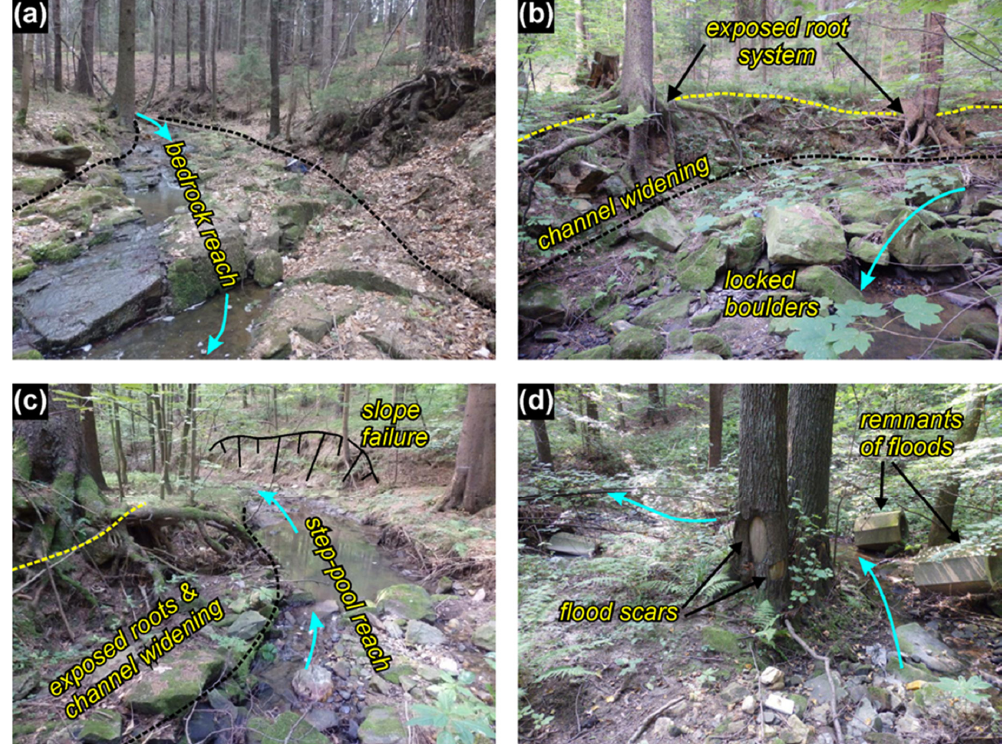
Figure 2. Morphological features of the study channel reach: ( a ) channel bottom composed of gneiss bedrock; ( b ) channel widening evidenced by the system of exposed tree roots in boulder-step reach; ( c ) step-pool reach with the presence of channel widening and fresh, shallow slope failure; ( d ) flood scars (higher older, and lower younger) on the tree stem of A. glutinosa in the direction of flow (note the remnants of concrete parts of centring transported by past floods).